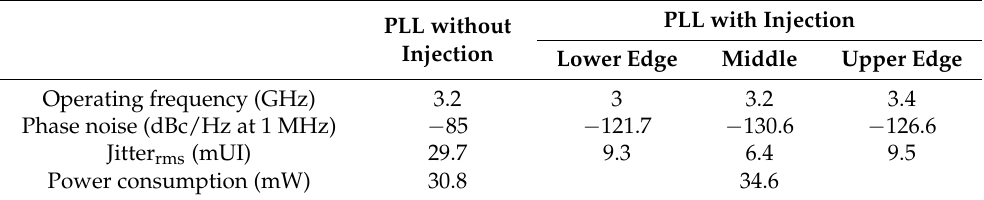
Table 1. Summary of phase noise, jitter, and eye opening performances of the PLL without and with injection locking.